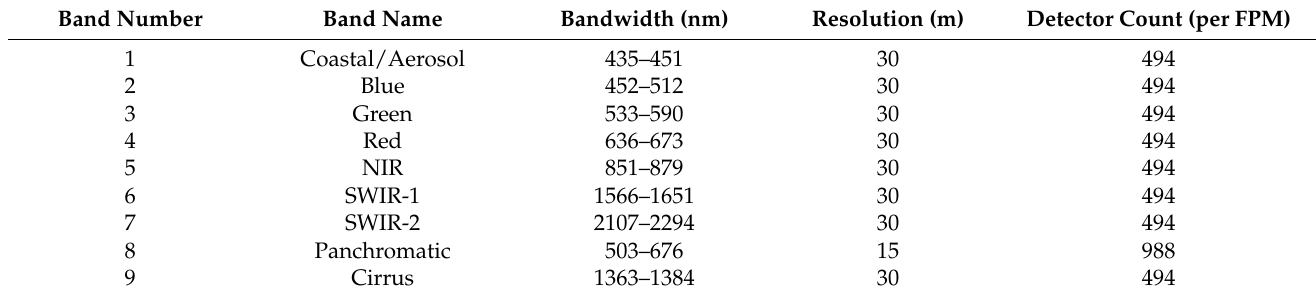
Table 1. OLI spectral bands and resolution [3].